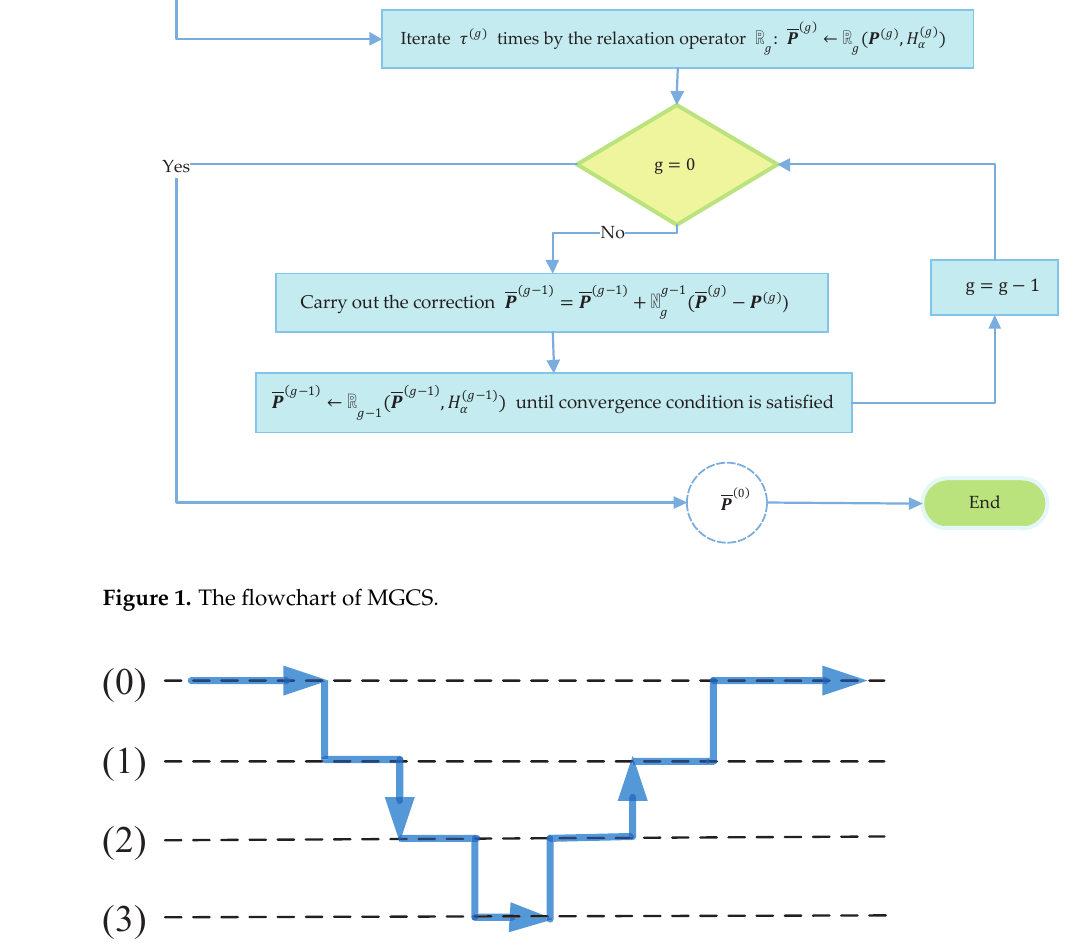
Figure 2. The V-cycle multigrid iteration